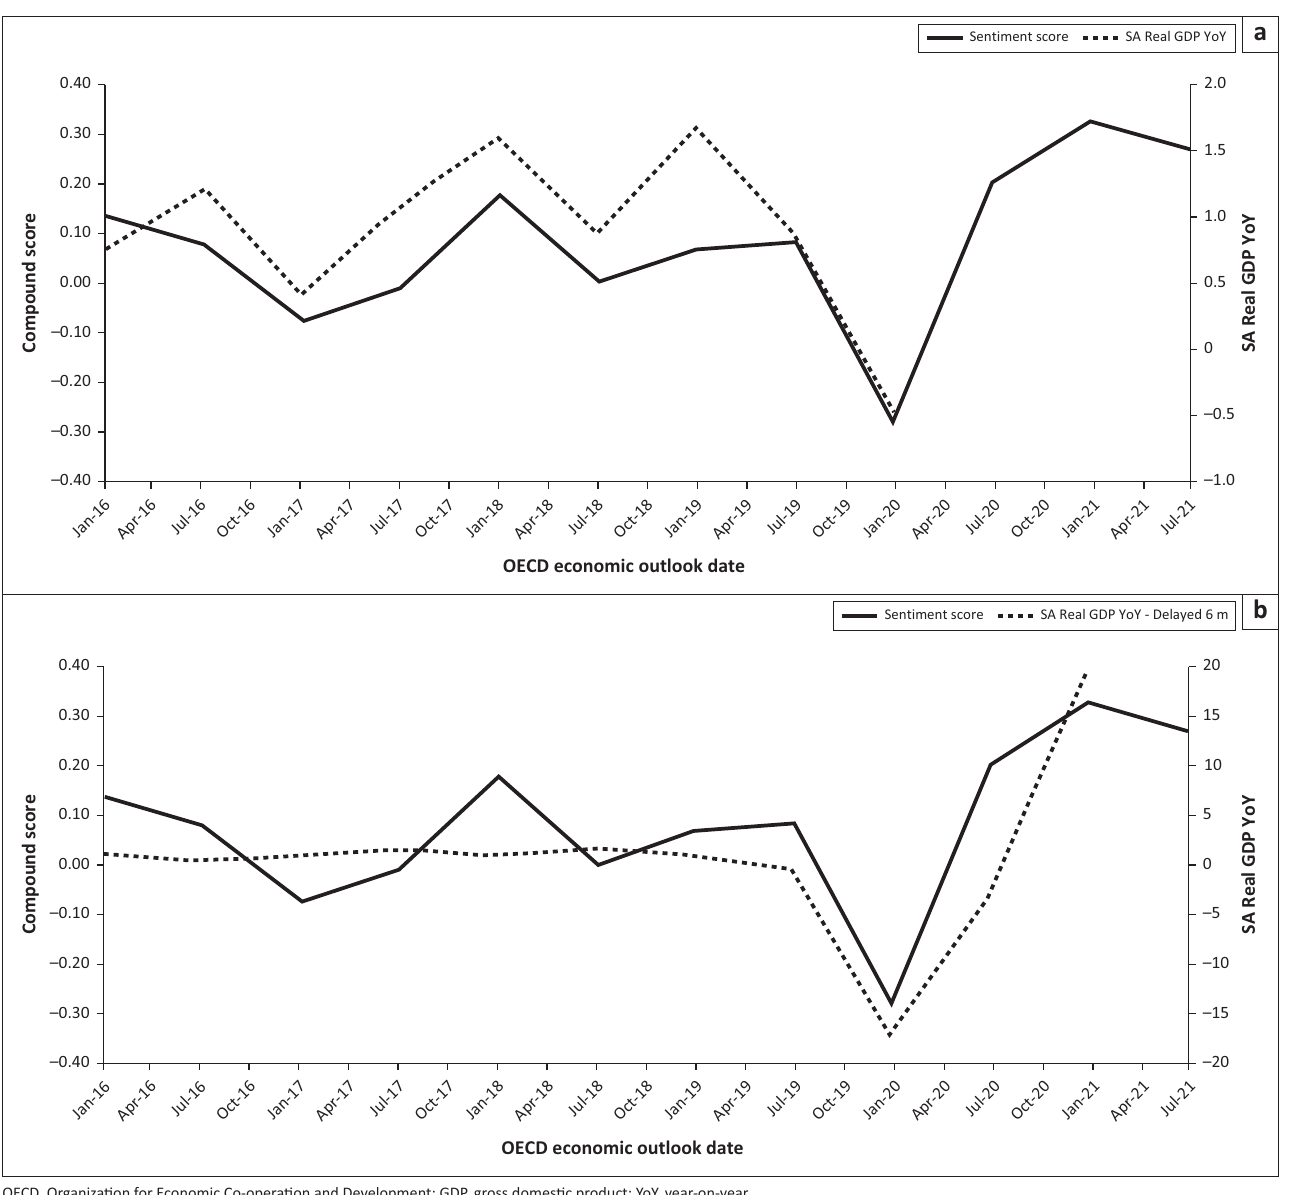
FIGURE 4: A comparison of the compound sentiment score derived with FinBERT from the Organization for Economic Co-operation and Development economic outlook for South Africa from 2016 to 2021 and the observed gross domestic product